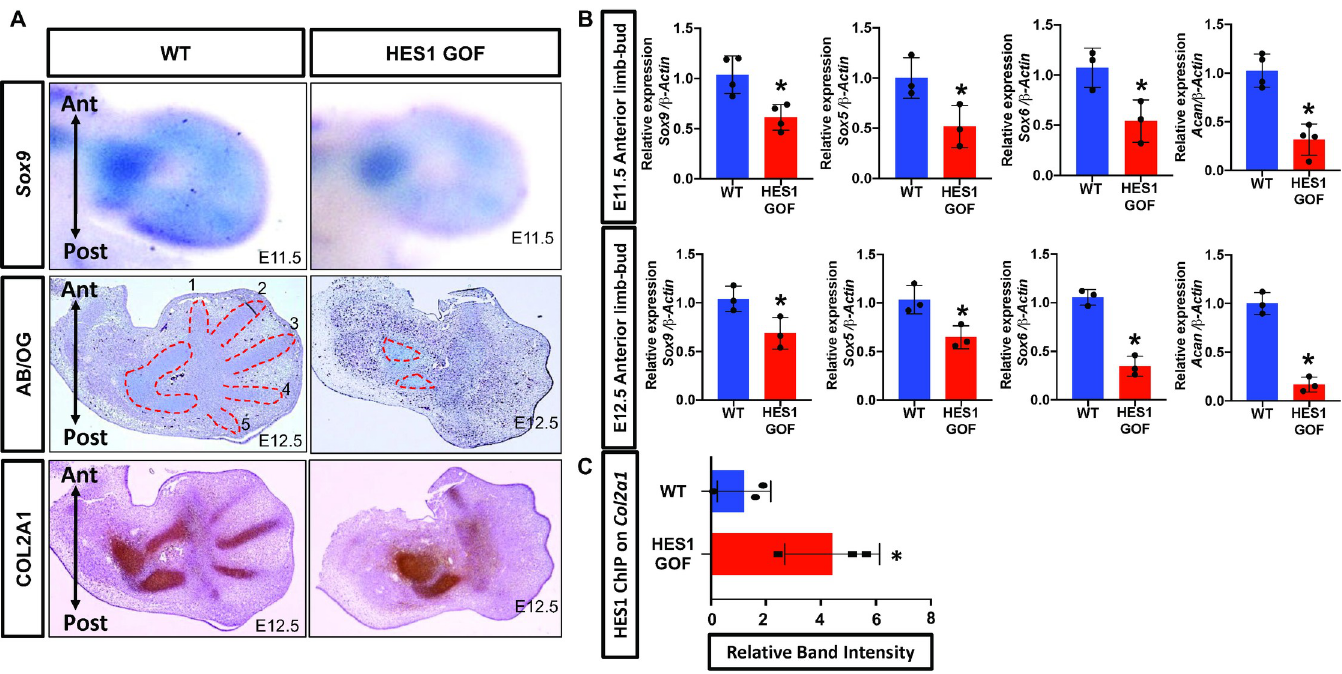
Fig 3. Hes1 over-expression within limb bud mesenchyme delays chondrogenesis. (A) WISH for Sox9 on WT and HES1 GOF E11.5 limb buds. ABH/OG staining of WT and HES1 GOF E12.5 limb bud sections. COL2A1 IHC staining of WT and HES1 GOF E12.5 limb bud sections. (B) qPCR for Sox9 , Sox5 , Sox9 , and Acan utilizing RNA from anterior limb bud halves of E11.5 and E12.5 WT and HES1 GOF embryos (N � 3; p-value < 0.05; Student’s t-test) Each data point represents separate animals (C) Densitometry measurements of ChIP PCR amplifications from the chromatin containing a N-Box within the Col2a1 enhancer of WT and HES1 GOF limb buds (N = 3; p-value < 0.05; Student’s